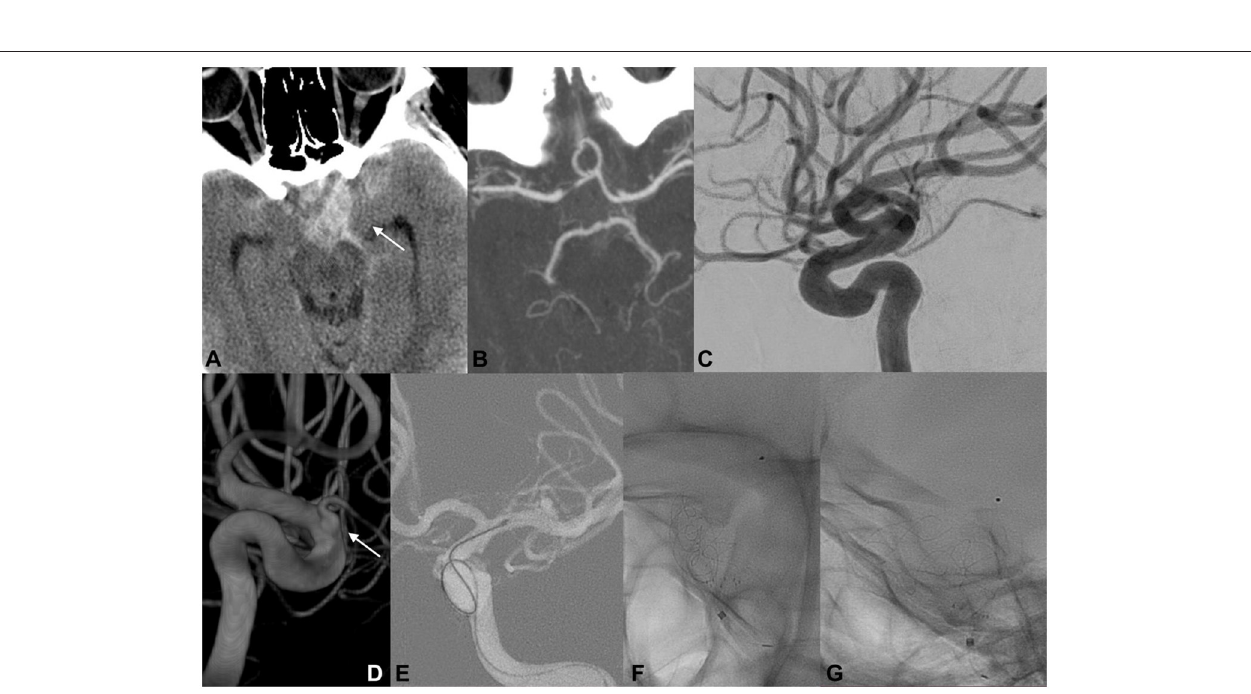
FIGURE 3 | EVT of ruptured OA ID in a young woman. The initial radiological work-up indicated intracranial hemorrhage, suggesting the rupture of an intracranial aneurysm ( A ; white arrow). Cranial CTA and initial DSA did not reveal any cerebrovascular pathologies that could be associated with the hemorrhage (B,C) . Three-dimensional rotational angiography demonstrated the presence of an ID at the level of the orifice of the left ophthalmic artery ( D ; white arrow). Endovascular FD deployment was performed with complete coverage of the OA infundibular orifice (E–G) .